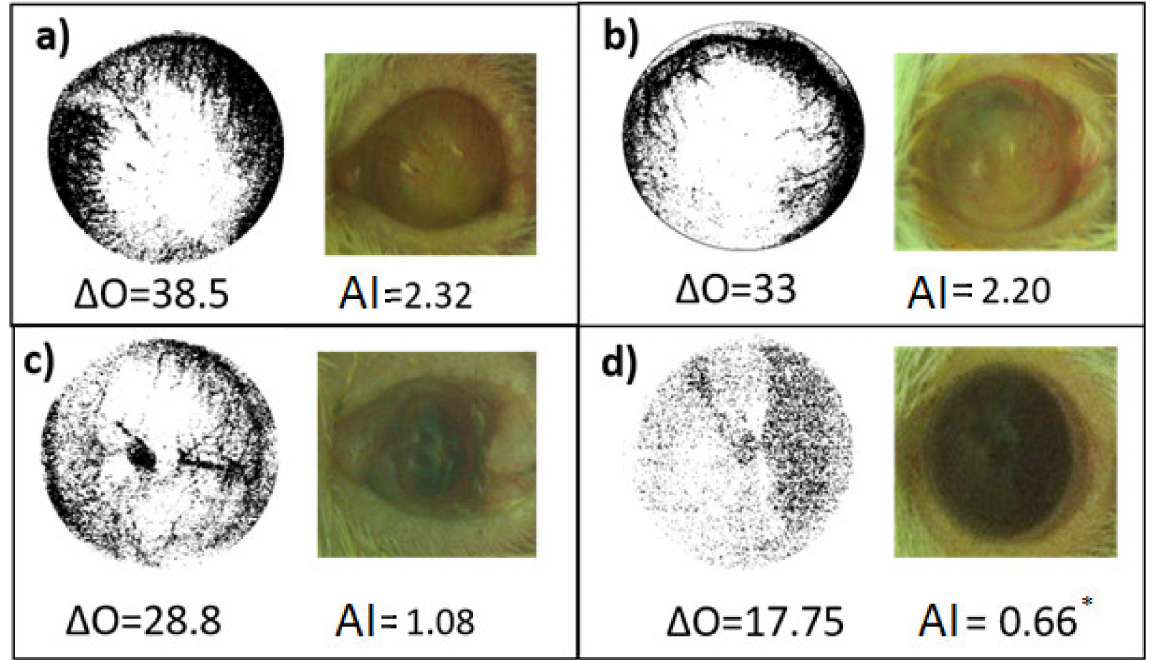
Figure 5. Comparison of the angiogenesis index (AI) and the opacity value ( ∆ O) at the end of the evaluation with respect to the treatment applied. ( a ) Negative Control Group; ( b ) Positive Control Group; ( c ) Experimental Treatment Group; ( d ) Basal Group. ANOVA post Bonferroni test. * p < 0.05 is different when compared with negative group (n =